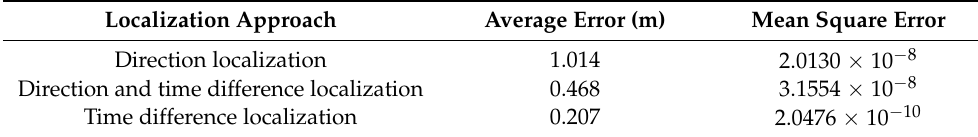
Table 1. Observation errors in each cooperative localization